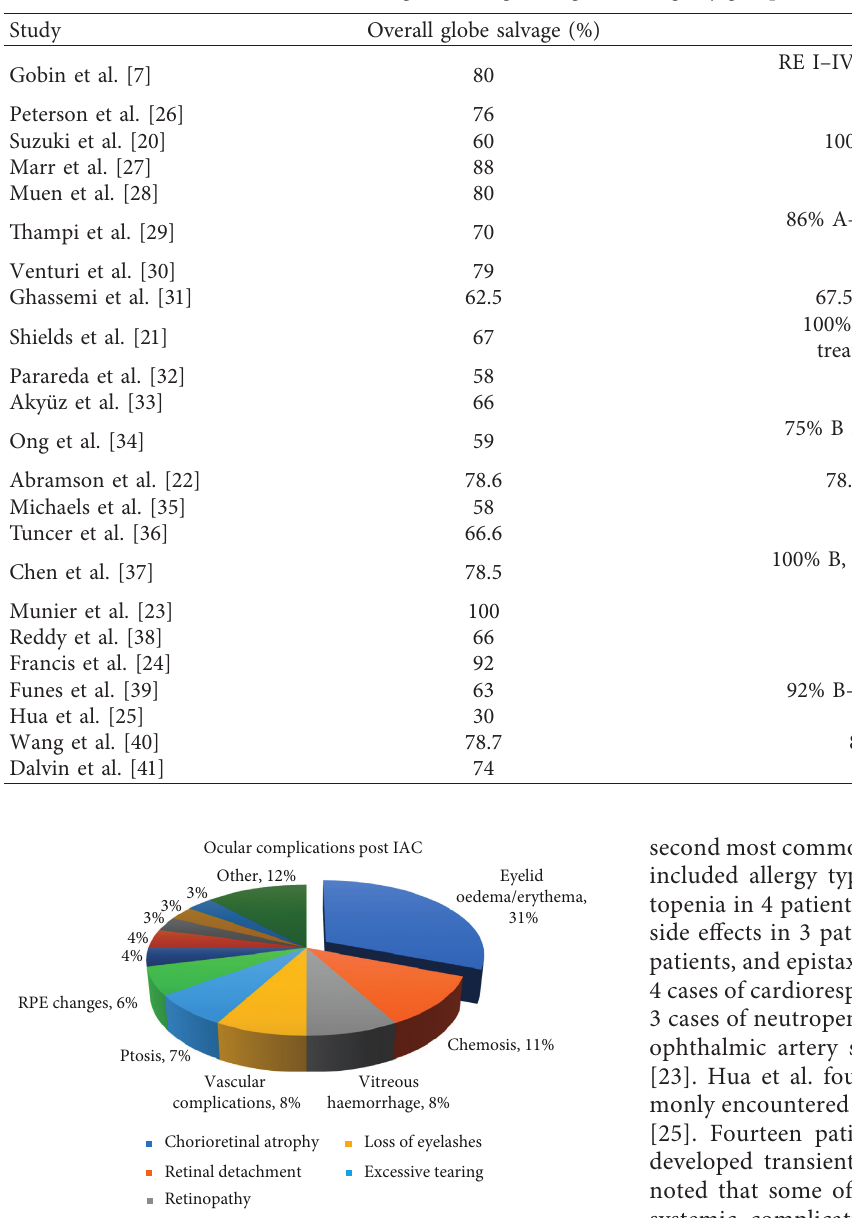
Figure 6: Ocular complications following IAC.